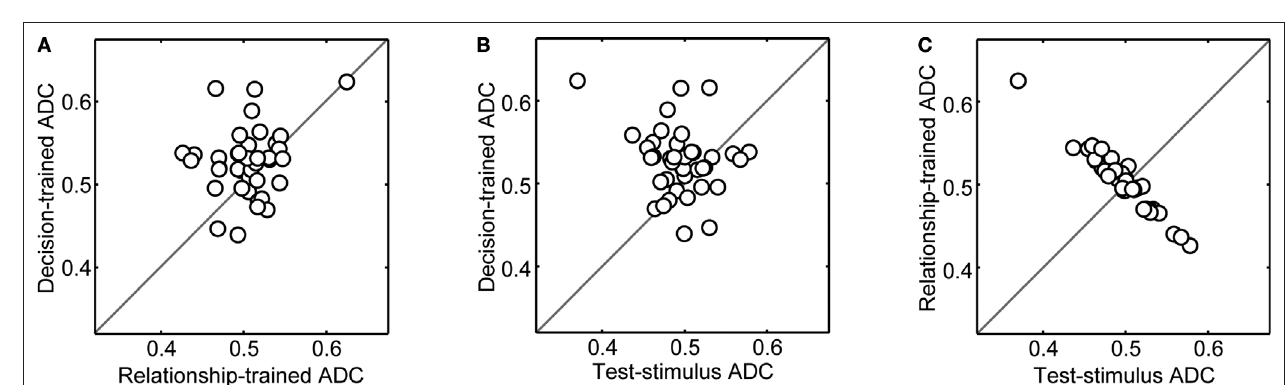
and relationship-trained-ADC values are compared. In panel (B) , the decision- trained-ADC values and test-stimulus-trained-ADC values are compared. In panel (C) , the test-stimulus-trained-ADC values and relationship-trained-ADC values are compared. In each panel, the solid line is the line of equal ADC value.